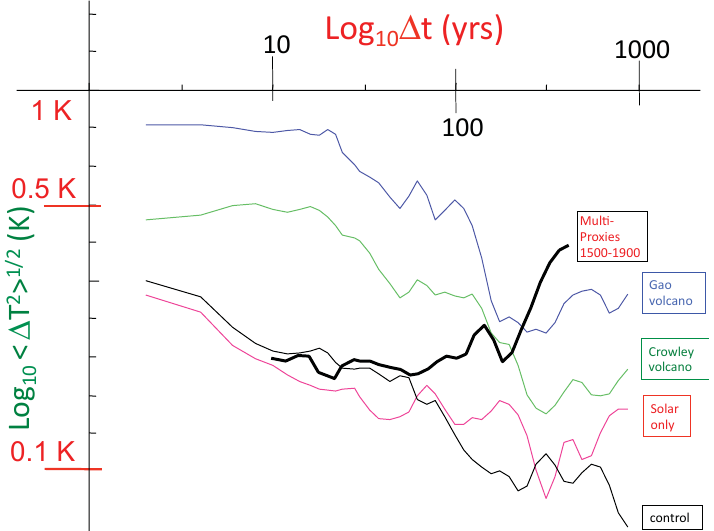
Fig. 6. Preindustrial multiproxy and GISS-E2-R RMS fluctuations. Same as Fig. 5 except for the preindustrial period (1000–1900), the lower black curve is the GISS-E2-R control run from Fig.